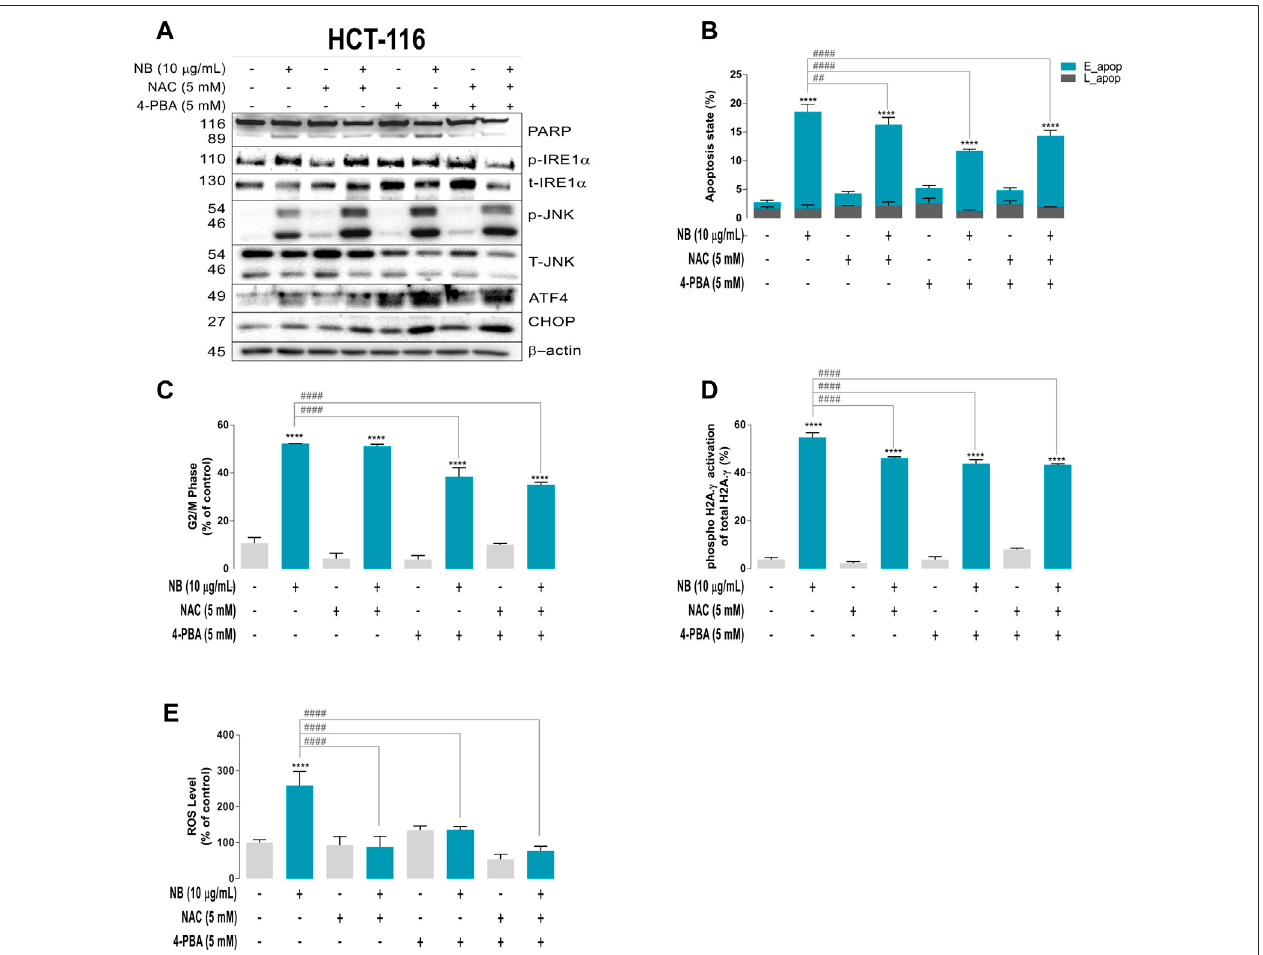
FIGURE 4 | Relationships between ROS and ER stress induced by NB extract in the colon cancer HCT-116 cell model. Cells were pretreated with the ROS scavenger N-acetyl-cysteine (NAC, 5 mM) and ER stress inhibitor 4-phenylbutric acid (4-PBA, 5 mM) for 2 h prior to 10 μ g/ml NB extract treatment. NB extract modulation of ER stress – related proteins (PARP, phospho-IRE1 α , total-IRE1 α , phospho-JNK, total-JNK, ATF4, and CHOP) was analyzed by western blot analysis (A) . β -Actin was used as a loading control. The experiment was repeated twice. Apoptosis (B) , G2/M phase (C), and phosphorylation of H2A. γ (as DNA damage indicator) (E) were measured using a Muse ® cell analyzer according to the manufacturer ’ s instructions. ROS levels were measured using the 2 ′ ,7 ′ - dichlorodihydro fl uorescein diacetate